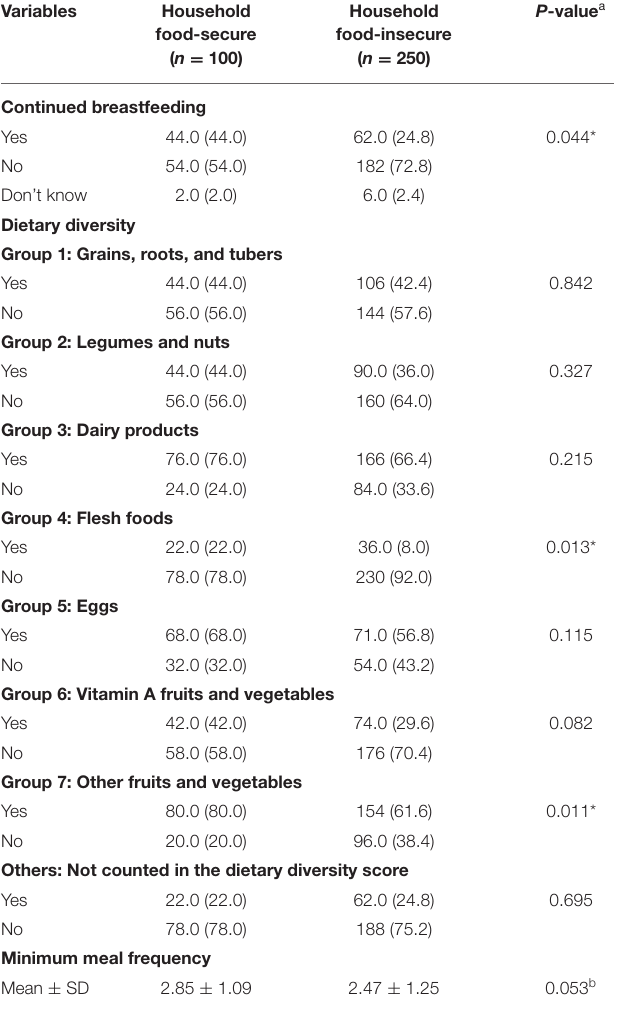
TABLE 5 | The overall knowledge, attitudes, and achieved minimum dietary diversity score of under-five children by household food-security status ( n = 350). Variables Household